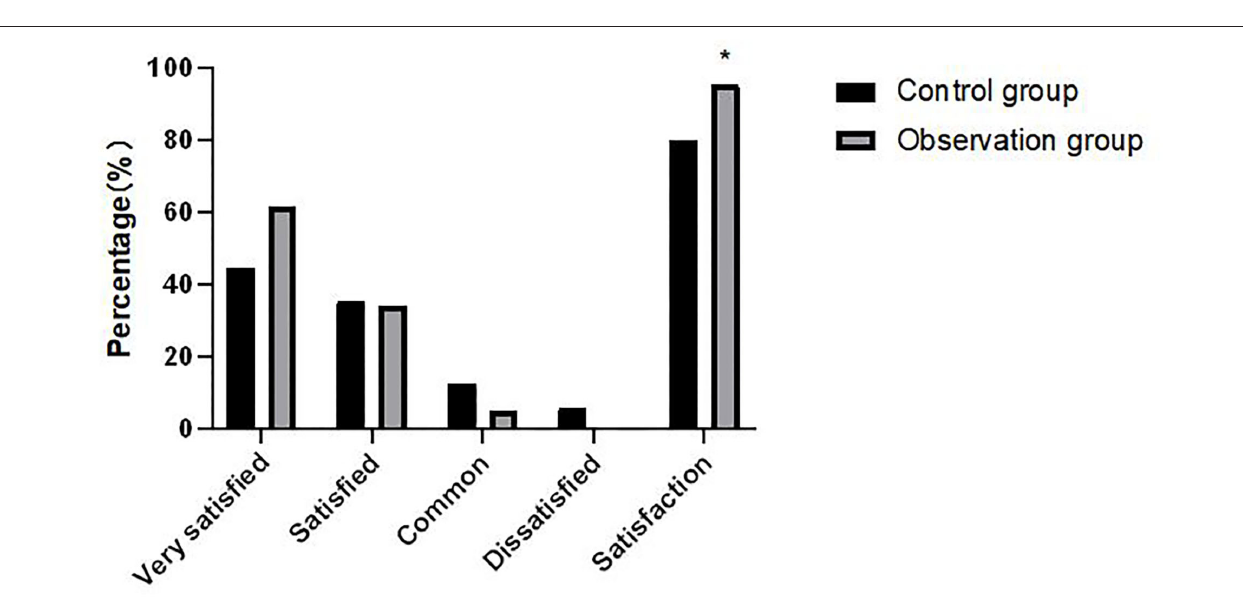
FIGURE 2 | Comparison of nursing satisfaction between two groups of patients. Compared with the control group, * χ 2 = 9.049, P =